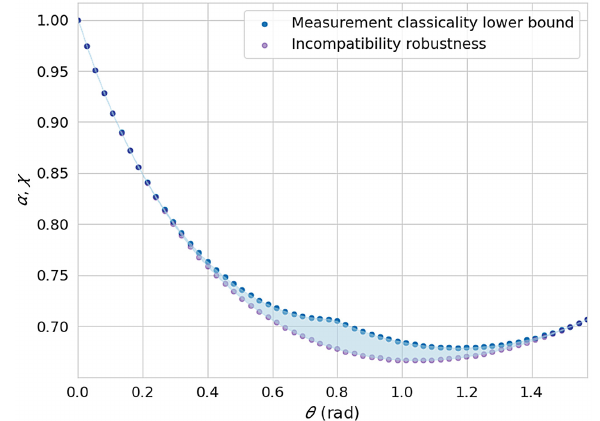
FIG. 7. Incompatibility is insufficient for nonclassicality in the PAM scenario. For each θ (see Fig. 6), any χ above the incompatibility robustness curve stands for an incompatible mea- surement set, and any α below the measurement classicality lower bound represents measurements that certifiedly do not gen- erate nonclassical statistics, regardless what preparations they act upon. Thenceforth, the shaded region contains incompatible albeit classical